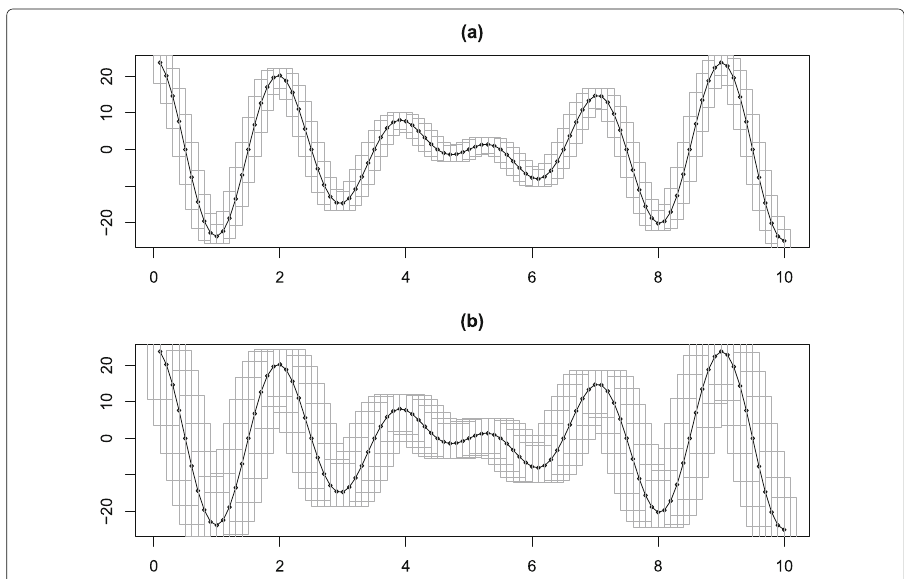
( X ) of signal X = 25cos ( 0.1 π t ) cos (π t ) , 0 ≤ t ≤ 10. a τ = 2 and b t t i